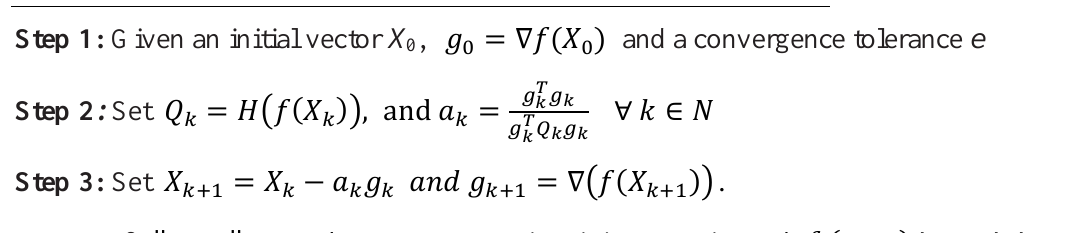
Algorithm 1. Steepest Descent